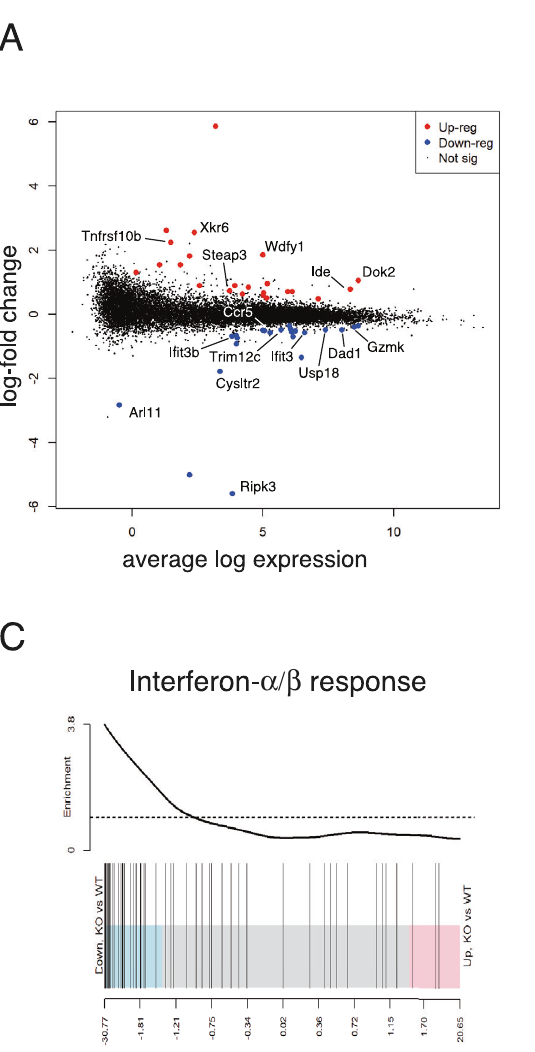
RNA sequencing revealed perturbations in interferon signaling pathways in Ripk3 -/- virus-speci fi c CD8 + T cells We attempted to identify a potential mechanism underlying the differential clearance kinetic in RIPK3-de fi cient animals, and performed unbiased RNAseq analysis of FACS-sorted virus-speci fi c CD8 + T cells from WT and Ripk3 − / − mice at 14-days post-infection with LCMV docile. A total of 46 genes were identi fi ed to be differentially expressed (DE) between WT and Ripk3 − / − CD8 + T cells at this time point (Fig. 5A – B). Pathway analysis revealed dysregulation in cytokine signaling and a depressed type I interferon (IFN-I) response and a downregulation in interferon signaling in CD8 + T cells from Ripk3 − / − mice compared to WT mice (Fig. 5C, D).